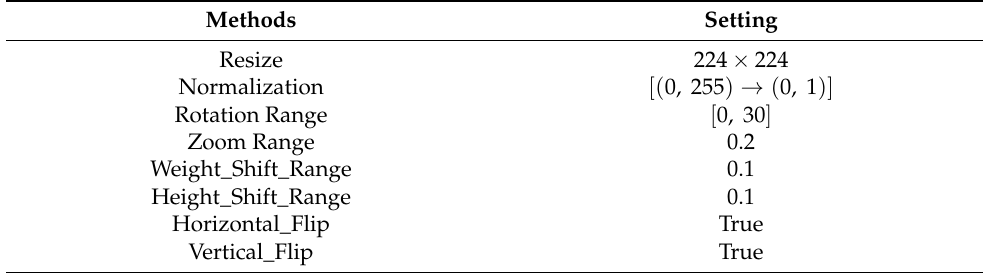
Table 2. Data pre-processing techniques used in this